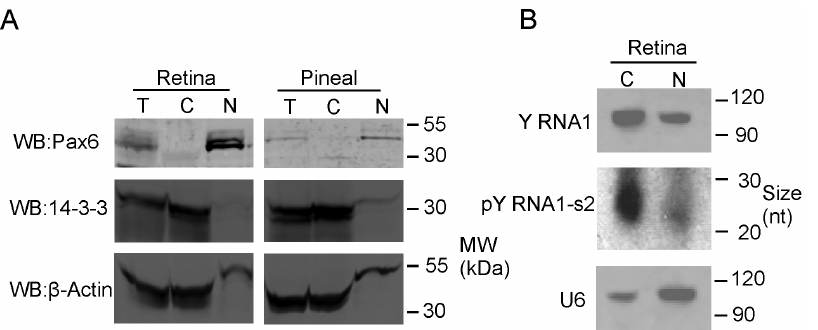
Figure 5. Cellular distribution of Y RNA1 and pY RNA1-s2. A. Retinal tissue was obtained from three animals, pooled and dissociated in lysis buffer with the addition of RNAse inhibitors, as described in ‘‘Materials and Methods’’. These preparations were pooled and partitioned into nuclear and cytoplasmic fractions. Equal proportions of each fraction were subjected to SDS-PAGE and western blotted for Pax 6 (nuclear fraction control), 14-3-3 (cytoplasmic control) and b -Actin (cytoplasmic control). B. Northern blot of total RNA extracted from cytoplasmic and nuclear fractions as described above, separated on a denaturing 15% TBE-Urea PAGE gel, using a probe directed toward pY RNA1-s2, indicating the predominance of pY RNA1-s2 in the cytoplasm, but also detectable in the nuclear fraction. The panel indicated by ‘‘Y RNA1’’ shows the un-processed Y RNA and the panel labeled ‘‘pY RNA1-s2’’ shows the processed Y RNA1 that migrates at , 27 nt. The blot was re-probed with a probe directed to U6 (as a control) indicating the majority is present in the